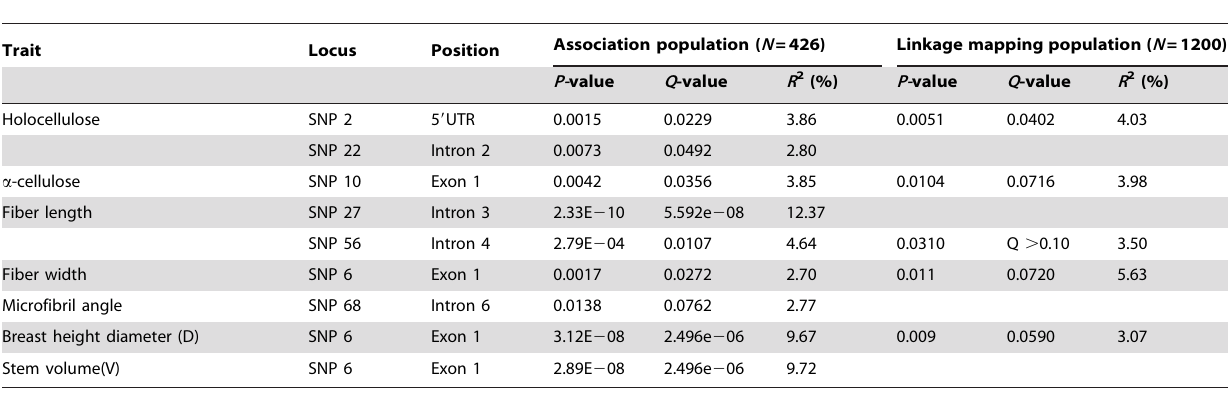
Table 4. Summary of significant SNP marker-trait pairs from the association test results in the discovery (association population) and validation (linkage mapping population) populations after a correction for multiple testing